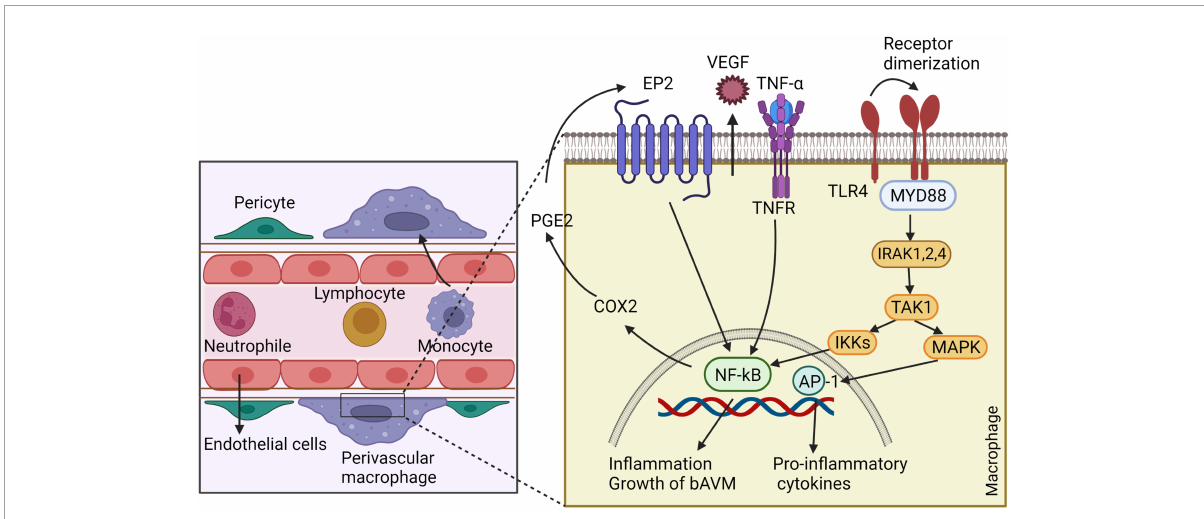
FIGURE4 The involvement of inflammatory cells in bAVM growth. Macrophages release VEGF, which regulates the development of ECs and vessel sprouting. By generating matrix proteases, macrophages degrade ECM to create a guiding pathway for proliferation and migration of ECs and facilitating vascular branching. Macrophages also have crucial role in recruitment of pericytes around new blood vessels by expressing high levels of PDGFB. Macrophages through triggering autocrine feedback loop of COX2, PGE2, EP2-NF-kB-COX2 results in bAVM prograssion. Likewise, macrophages express TLR4, which binds to myeloid differentiation primary response gene 88 (MyD88) and leads to the generation of complex with IRAKs and activation of inhibitor kappa B kinase β (IKK β ). This process leads to translocation of NF- κ B into the macrophage nucleus and overexpressing genes involved in inflammation. ECs: endothelial cells, COX2: cyclo-oxygenase 2, PGE2: Prostaglandin E2- EP2: prostaglandin E receptor subtype 2, MyD88: myeloid differentiation primary response gene 88, PDGFB: Platelet-derived growth factor B, TLR4: toll-like receptor 4, IRAKs: IL-1R-associated kinases, IKK β : inhibitor kappa B kinase β